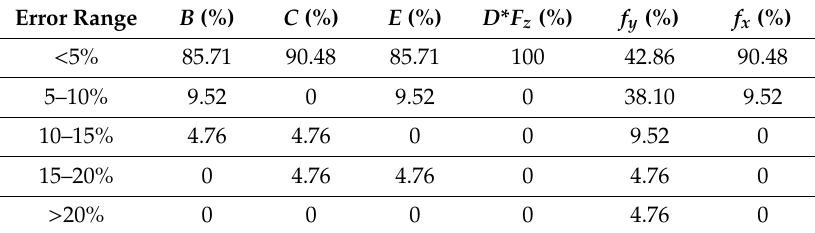
Table 3. Range of values for MF model parameters.